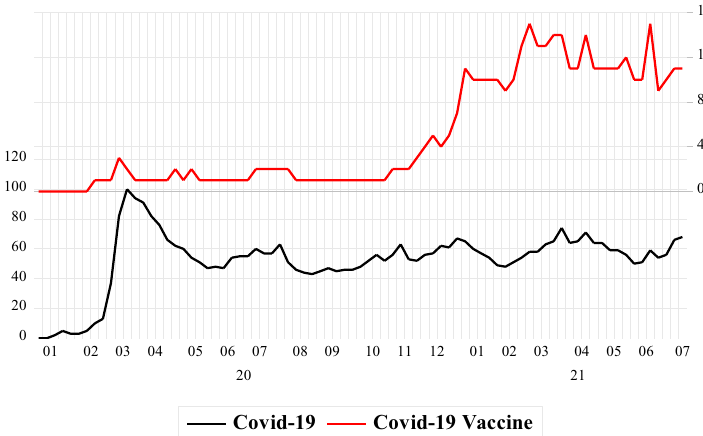
Fig. 1 Google Search Volume Index for “COVID-19” and “COVID-19 Vaccine” Terms. Note The left axis measures the search volume for “COVID-19” whereas the right axis measures “COVID-19 Vaccine”